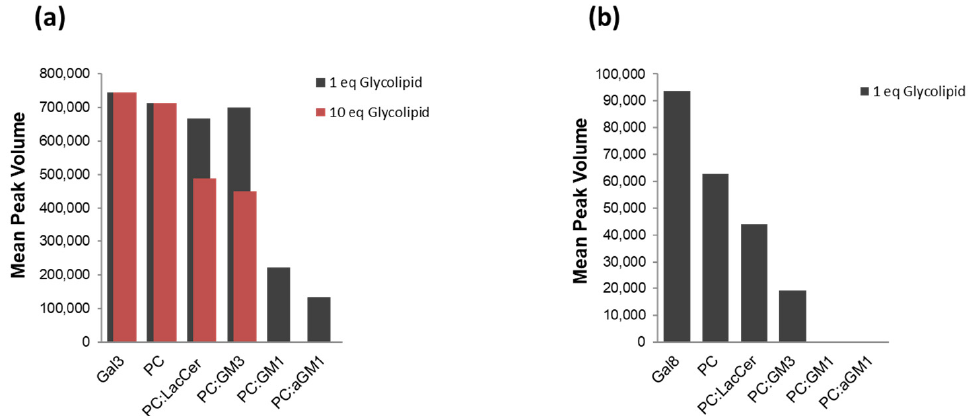
Figure 3. Quantification of the peak volume reduction of ( a ) 15 N-Gal3 CRD and ( b ) 15 N-Gal8N upon binding to liposomes containing only PC or the glycolipids LacCer, GM3, GM1, or aGM1. For Gal3, 1 eq and 10 eq of the corresponding glycolipid with respect to the protein is shown, while for Gal8N only the data with 1 eq glycolipid are shown, as with 10 equivalents all the HSQC cross peaks van- ished.